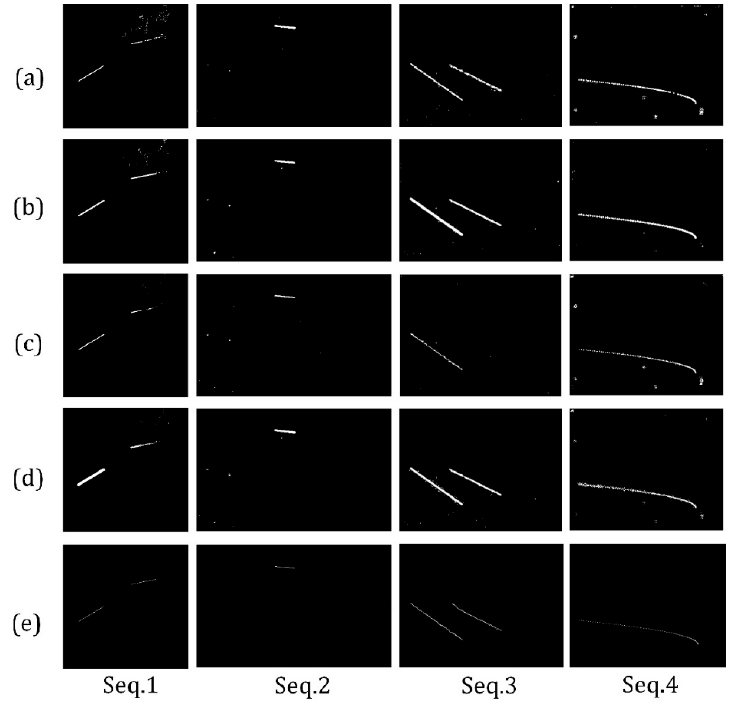
Figure 12. Cumulative results of inter-frame detection.